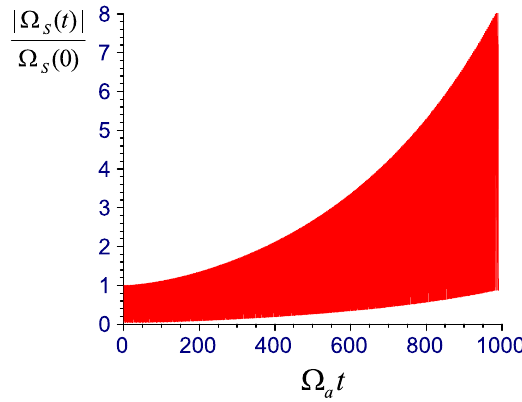
¼ 10 : 4(cid:4) ¼ 0 : 5(cid:4) , (cid:4) , and an ab a d a that maximizes d